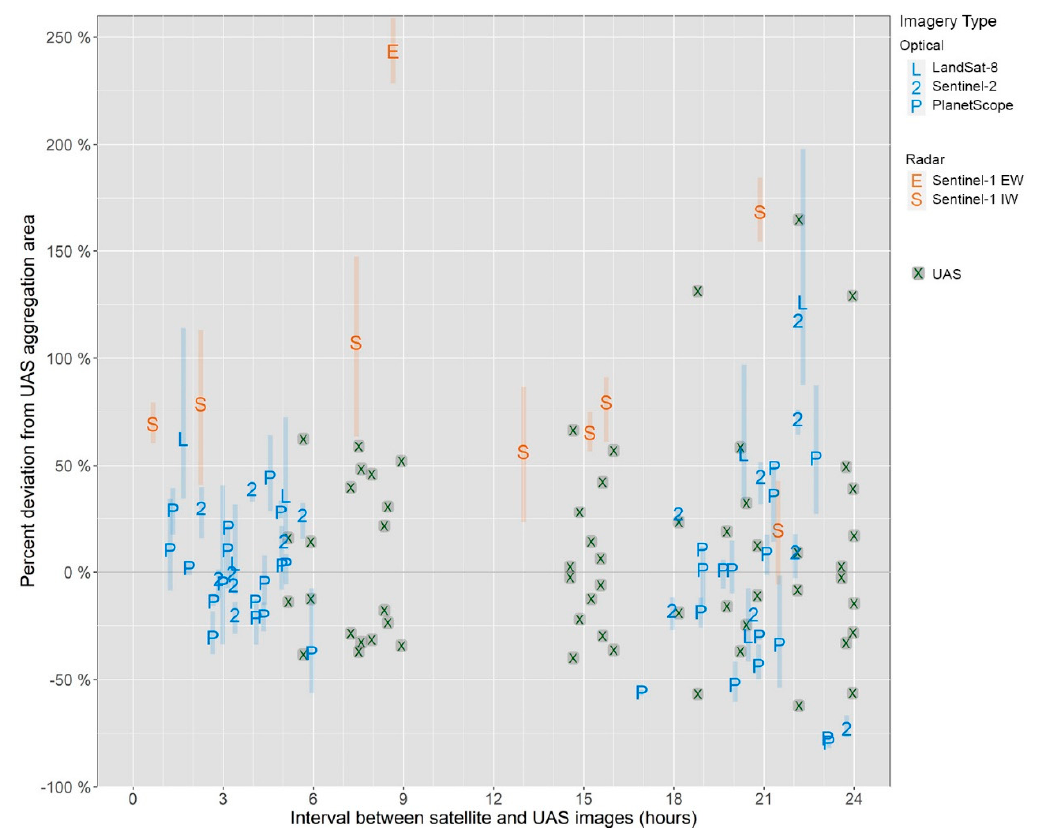
Figure 3. Deviation (percent) between satellite-derived areas of walrus occupancy and those obtained from matched UAS surveys, plotted on the amount of elapsed time between the two surveys (symbols, as in Figure 2). For each satellite image collected within 24 h of a UAS survey, the percent deviation was calculated as the area estimated from satellite imagery minus the area derived from the paired UAS survey, divided by the UAS survey area. Colored symbols indicate the mean percent deviation among the three observers and shaded vertical bars signify the full range of deviations. For comparison, the same deviations are plotted for UAS surveys matched to other UAS surveys (gray Xs). The plotted data are available as online Supplementary Materials.